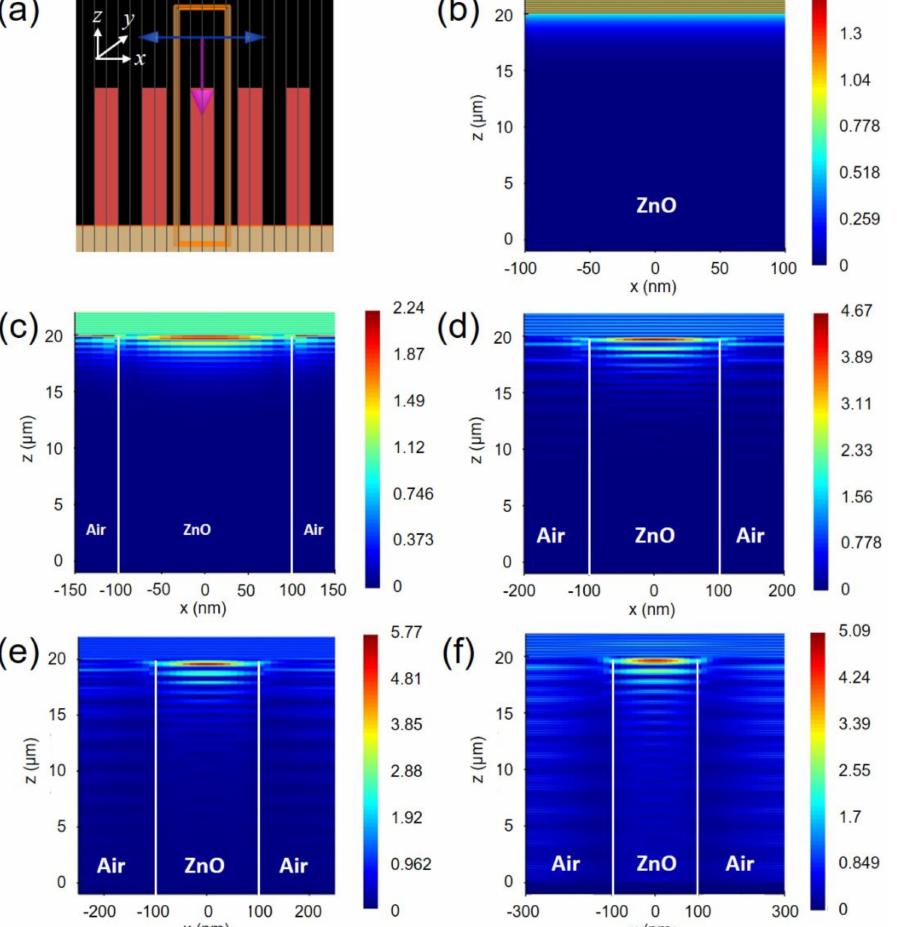
Figure 6. ( a ) The simulation structure for applying the FDTD (finite-difference time-domain) method. The electric-field intensity profiles inside the unit cell of the simulation structure for ( b ) 20-um thickness ZnO film and the 200-nm diameter ZnO NR arrays with an interspacing of ( c ) 100; ( d ) 200; ( e ) 300 and ( d ) 400 nm. The scale bar on the right of ( b ) to ( f ) represents the unit (V/m] of electric-field